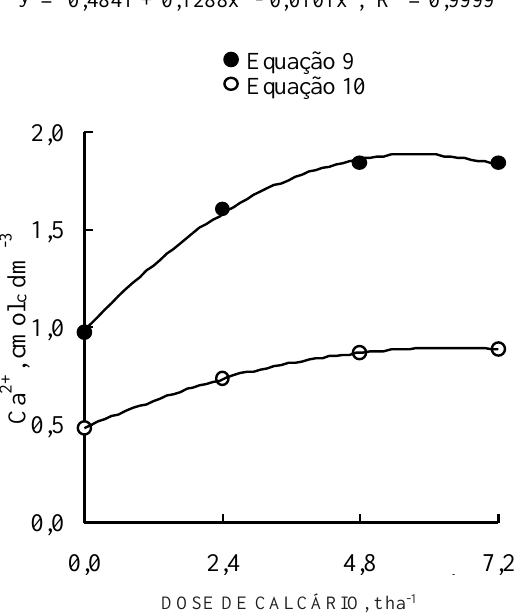
Figura 5. Teores de Ca 2+ de acordo com as doses crescentes de calcário distribuído na superfície do solo em 1999. As equações de regressões (linear e quadrática) variam de acordo com as camadas de solo (0–0,05 e 0,05–0,10 m) anos de amostragem (2000, 2001 e 2002).